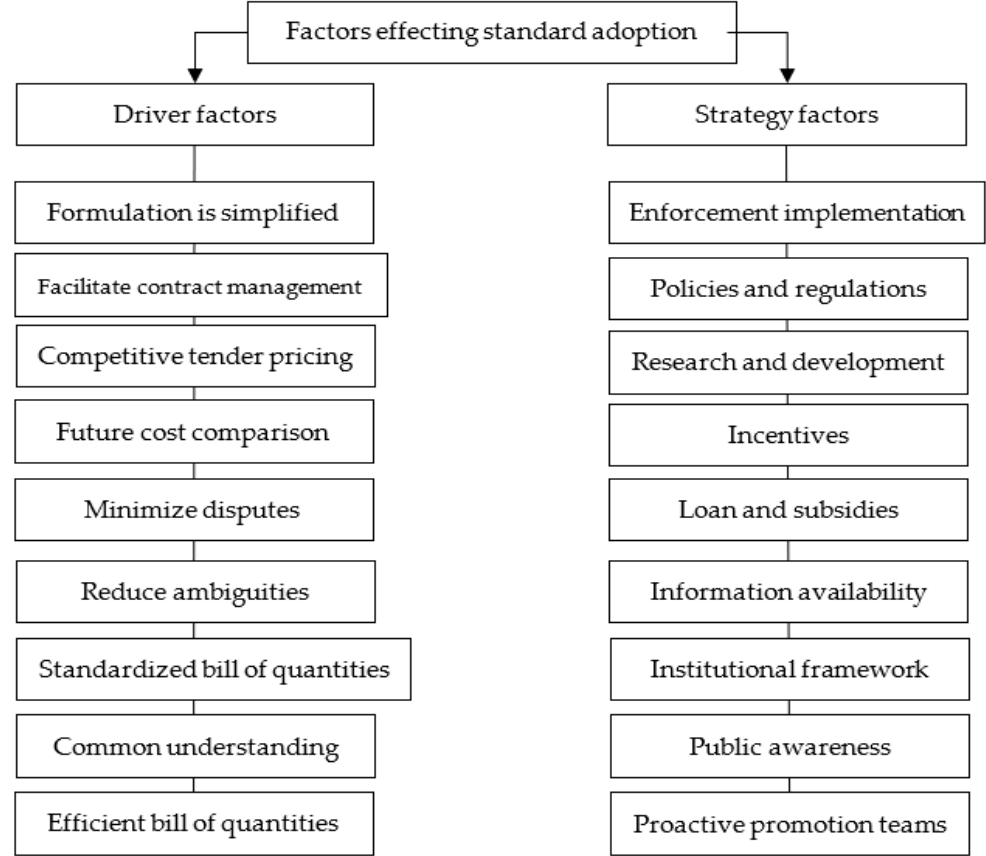
Figure 1. Driver and strategy factors in previous studies.